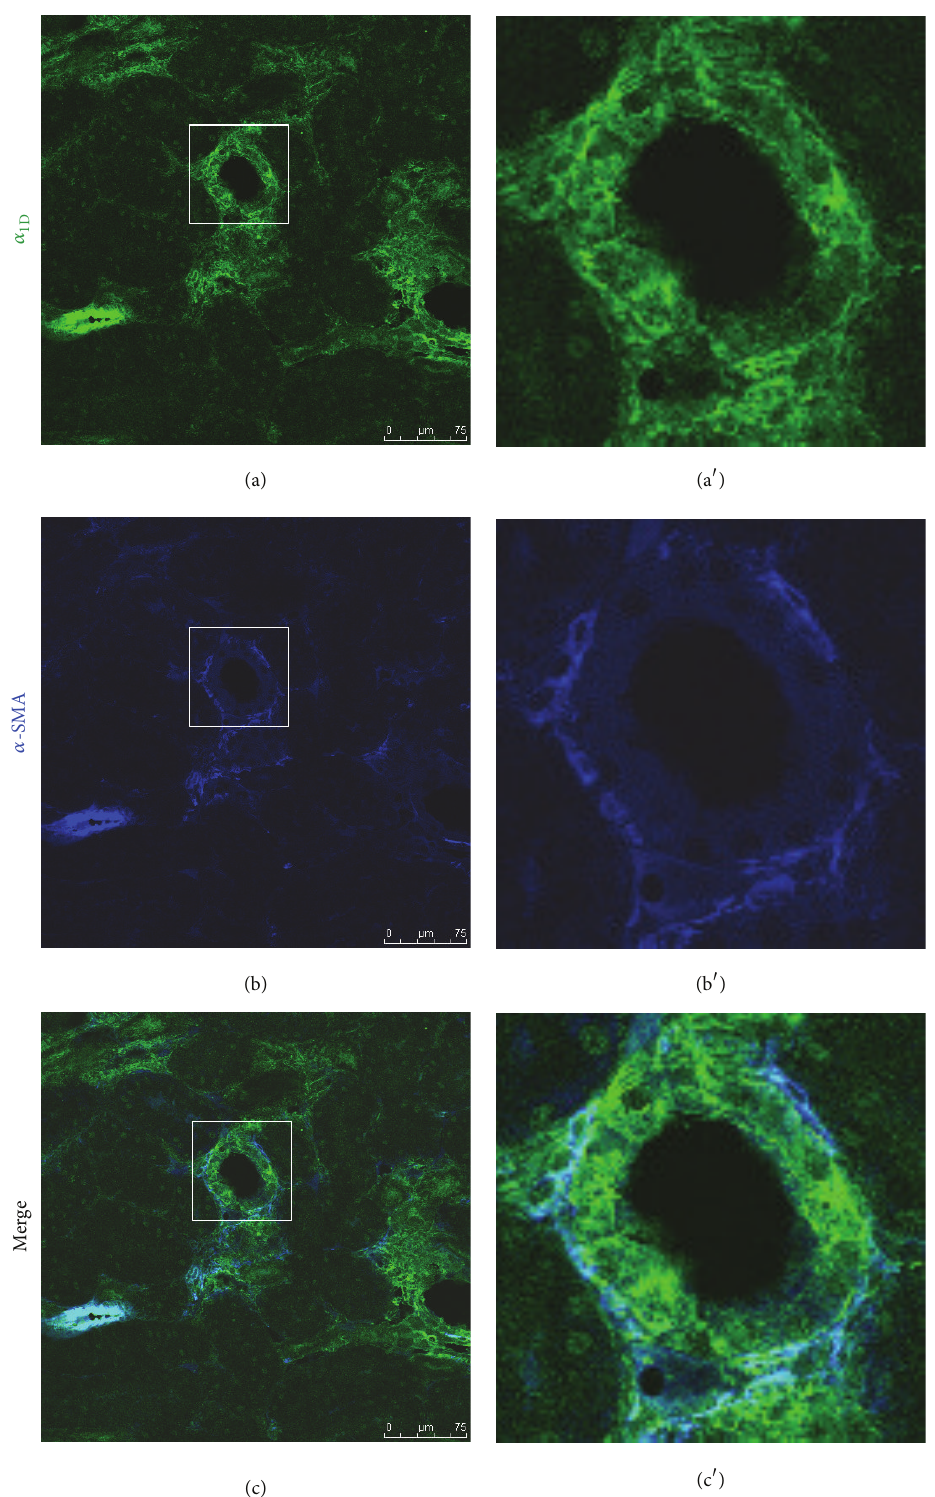
Figure 5: Increased tubulointerstitial 𝛼 1 -AR staining in the kidney of 20-week-old Zucker diabetic rats. In the diabetic kidneys, an induction D -AR protein (green) was detected in the epithelium of dilated tubules as well as the surrounding interstitial cells, which are 𝛼 -SMA- of 𝛼 1 D positive (dark blue). Images in (a 󸀠 ), (b 󸀠 ), and (c 󸀠 ) are enlarged from the boxed areas in (a), (b), and